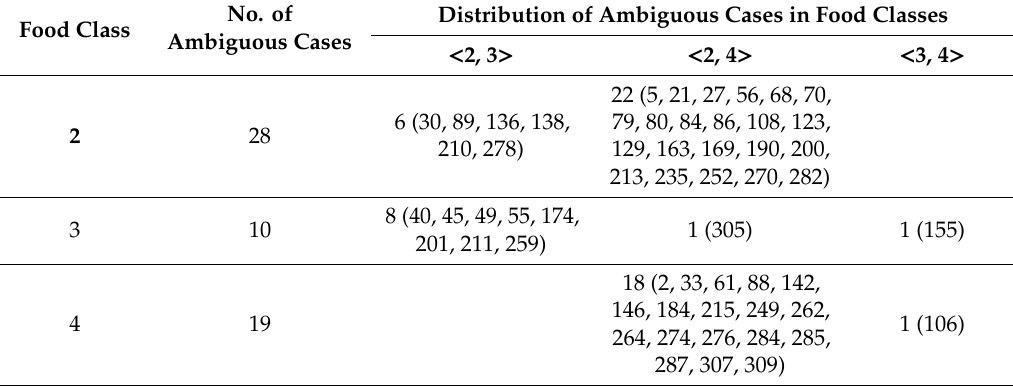
Table 7. The ambiguous cases for each food class and their distribution. Each number in brackets identifies an unclassified